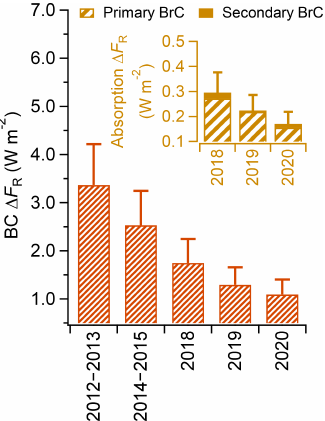
Figure 8. Temporal variations of the annual mean (cid:49)F R caused by BC, primary BrC, and secondary